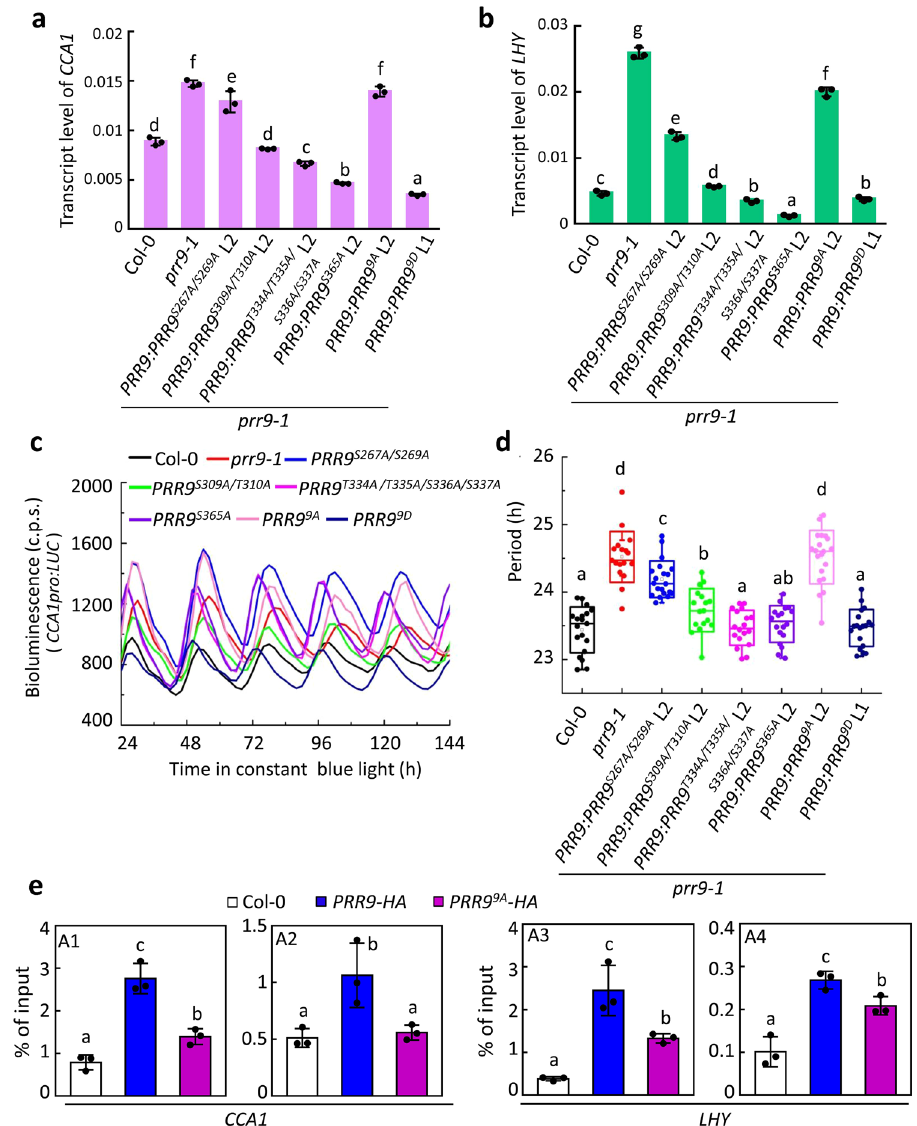
Fig. 4 | Phosphorylation is necessary for circadian function of PRR9. a , b Transcriptional expression levels of CCA1 ( a ) and LHY ( b ) in a variant of transgenic PRR9 phosphosites lines. 14-day-old seedlings of Col-0, prr9-1 , lines of PRR9 de-phosphorylation or phosphorylation mimicking variants in prr9-1 back- ground grown in LDcondition wereharvested atZT5 and tested by RT-qPCR. Data were mean±s.d., n =3, technical repeats. Lowercase letters indicate signi fi cant differencesbyone-wayANOVAfollowed byFisher ’ sLSDtest. c , d Bioluminescence tracesof CCA1pro:LUC ( c )andtheestimatedfree-runningperiod( d )ofseedlingsas described in a under continuous blue light (40 μ molm − 2 s − 1 ) condition. Lowercase lettersin d indicate signi fi cant differences by one-wayANOVAfollowed by Fisher ’ s